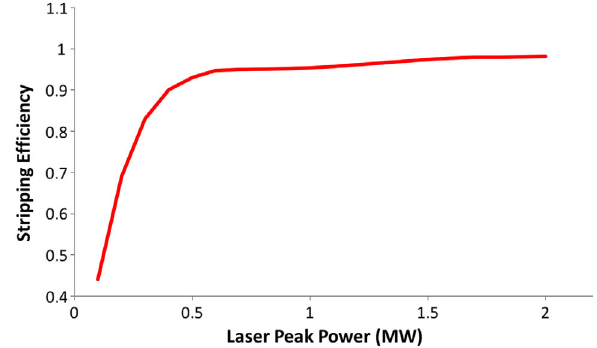
FIG. 6. BSM-measured longitudinal profile for the production beam configuration (wide profile) and the laser stripping con- figuration (narrow profile). Here, 1 ° ¼ 3 . 45 ps.